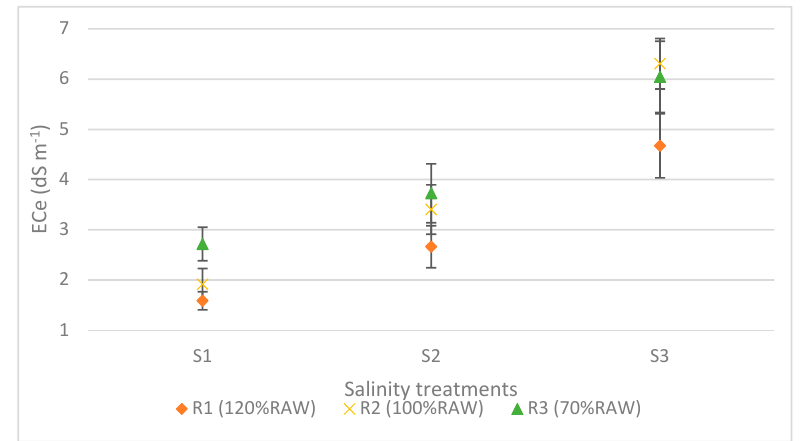
Figure 3. Mean soil salinity (ECe) at the end of the growing season in the field experiment for the three irrigation water salinity levels (S1, S2, and S3) with the three irrigation levels (R1, R2, and R3) which was determined by RAW (Readily Available